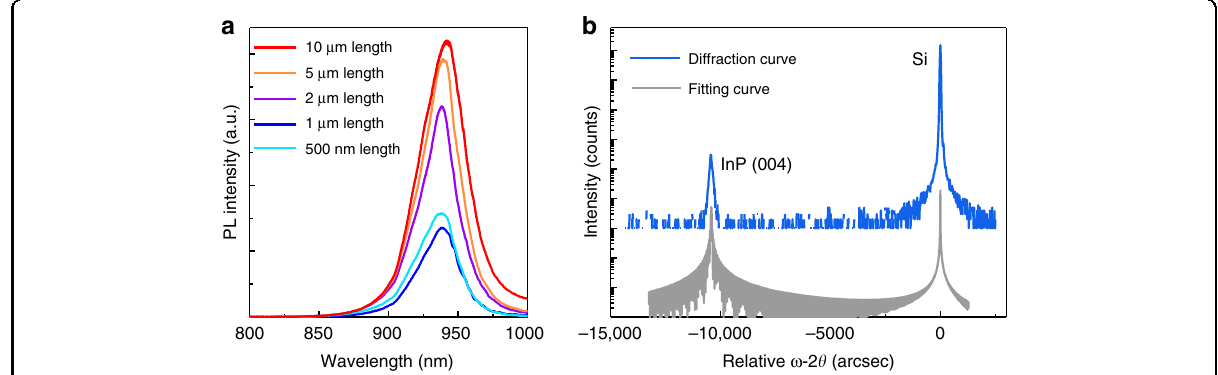
Fig. 4 Optical and crystalline characterizations. a Room temperature PL spectra of as-grown InP with different pattern length. b XRD relative ω -2 θ curve of as-grown InP array, and fi tting curve of 100% relaxed InP fi lms on